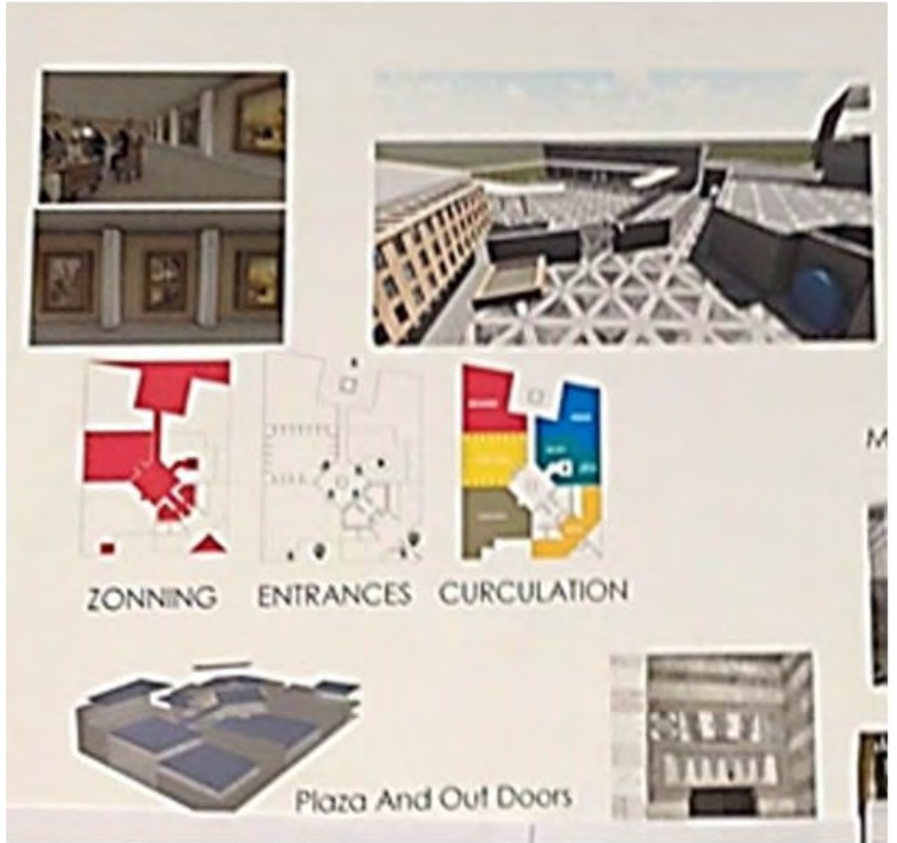
Figure 20. Layout showing building on boundaries and using courts (“Omar Abou Zeid’s”